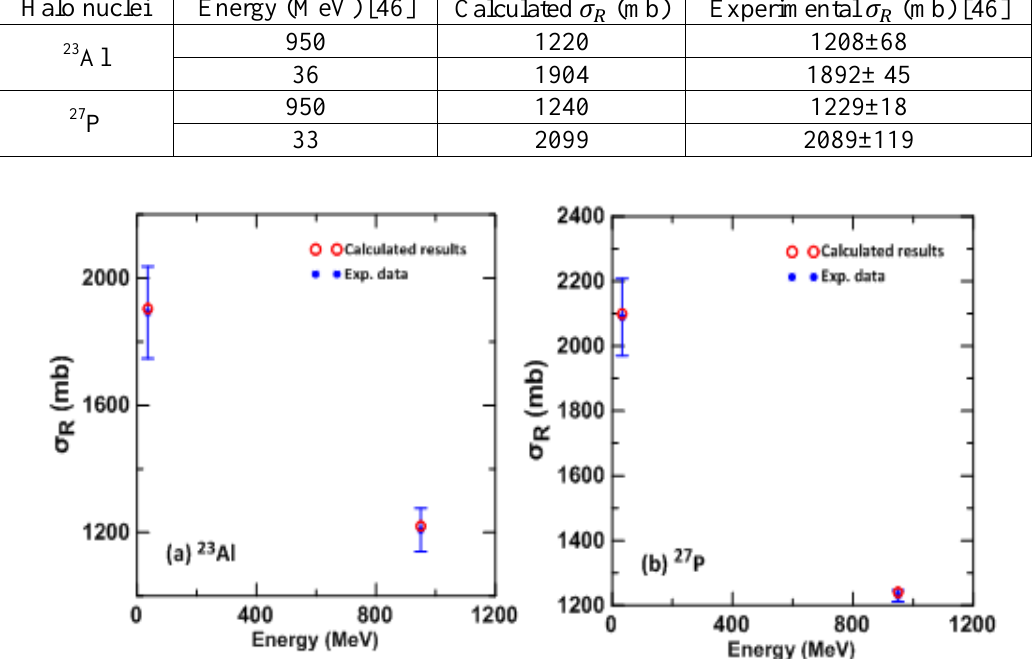
Fig. 6: The experimental and calculated results of reaction cross section for halo nuclei 23 Al and 27 P on 12 C